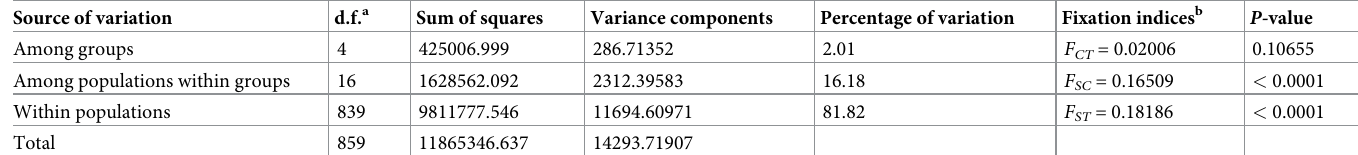
Table 3. Analysis of molecular variance of geographic groups and five subpopulations in the Korean core collection. Source of